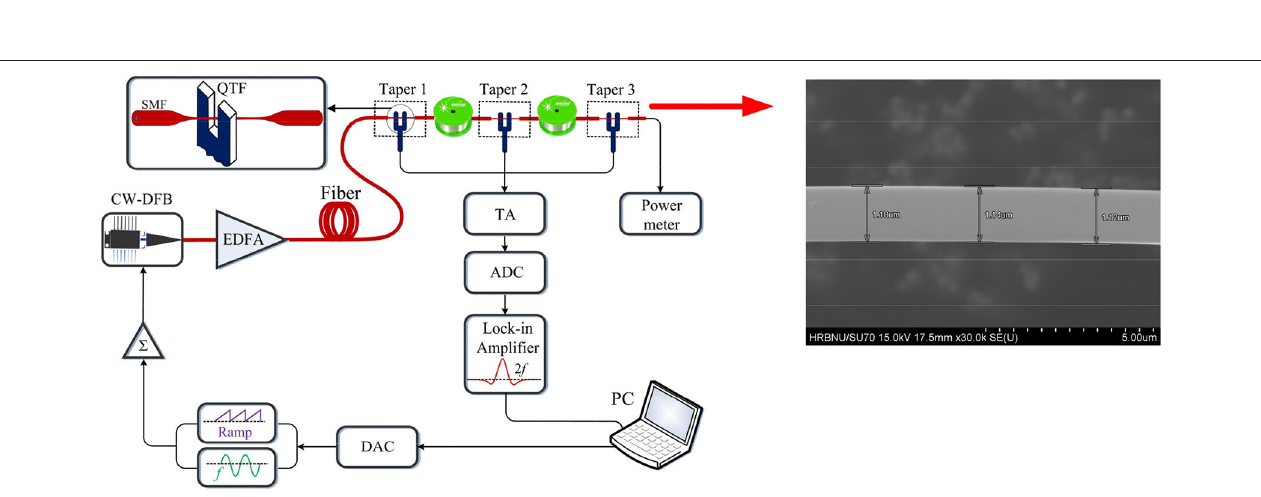
FIGURE 4 | Experimental setup of a FEW-QEPAS sensor. The insert is scanning an electron microscope (SEM) image of fiber taper. Reproduced from [86], with the permission of AIP